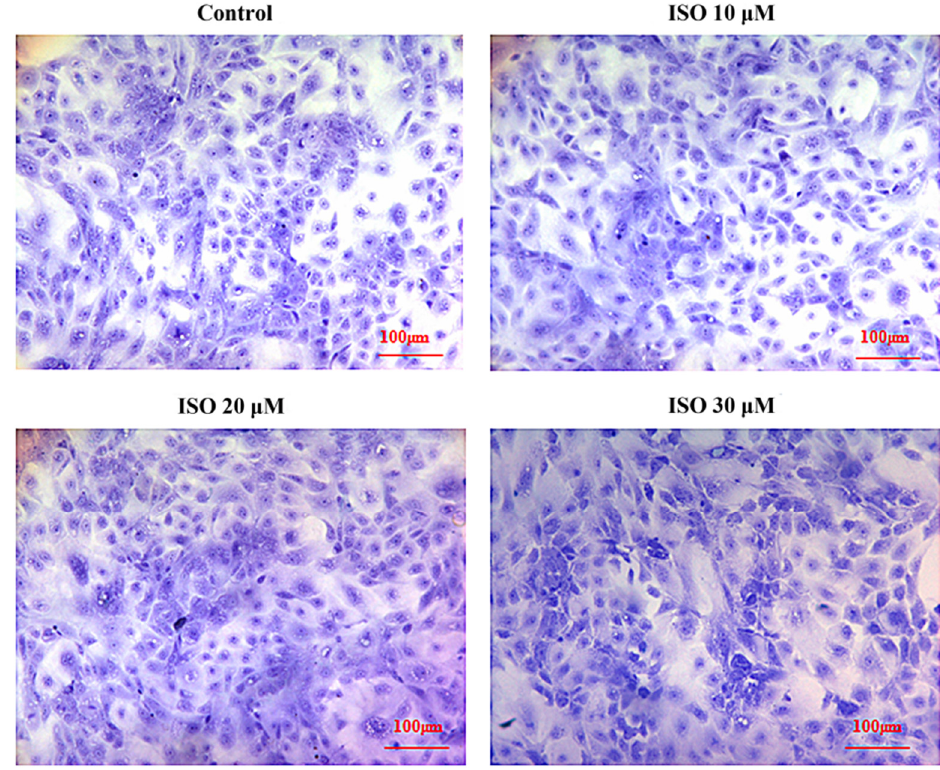
Figure 2. Effects of ISO on morphology of sow mammary gland cells. The morphology of the cell under different concentrations of ISO.